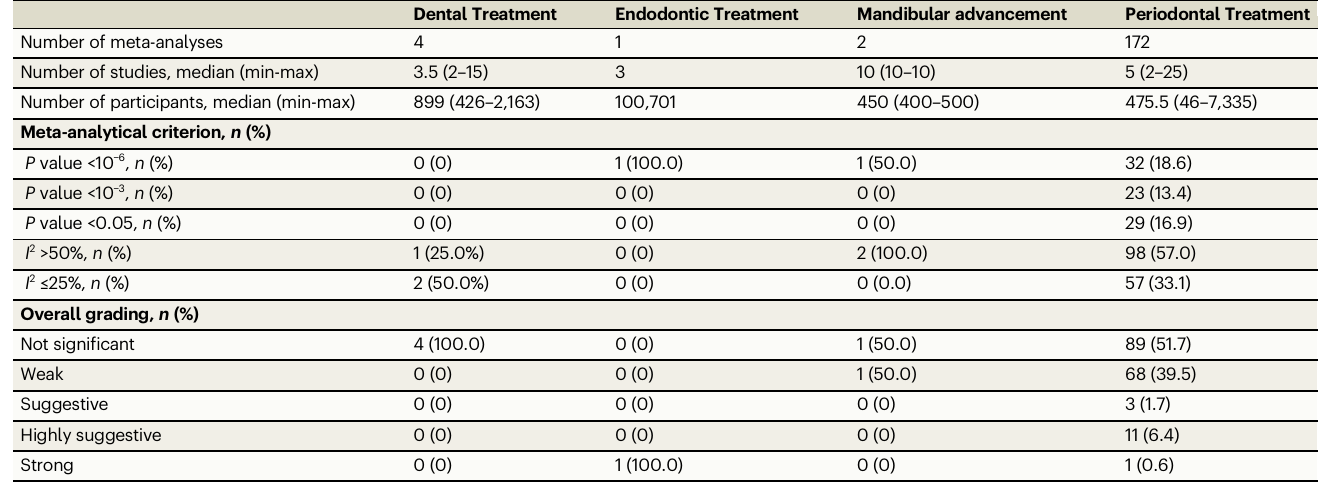
Table 2 | Descriptive statistics and evidence grading of the included meta-analyses of oral interventions Dental Treatment Endodontic Treatment Mandibular advancement Periodontal